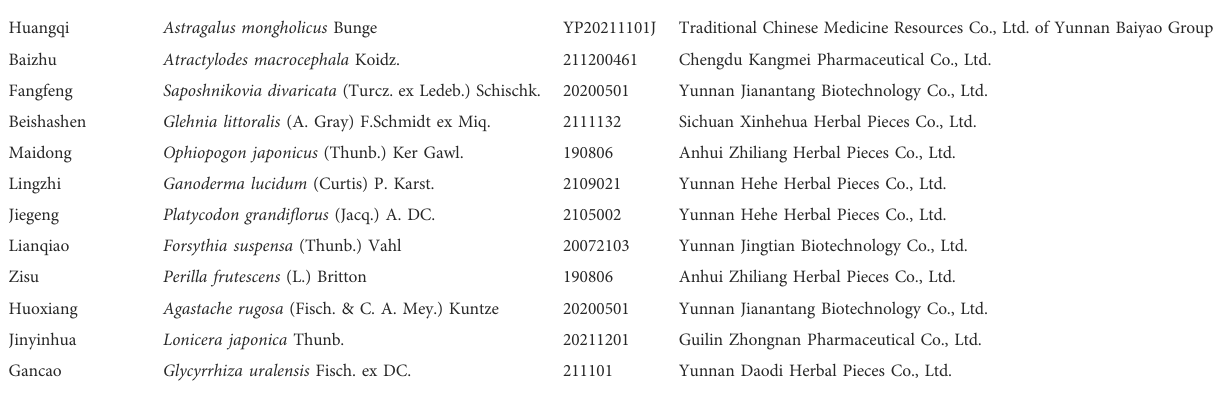
TABLE 1 Detailed information of herbs in